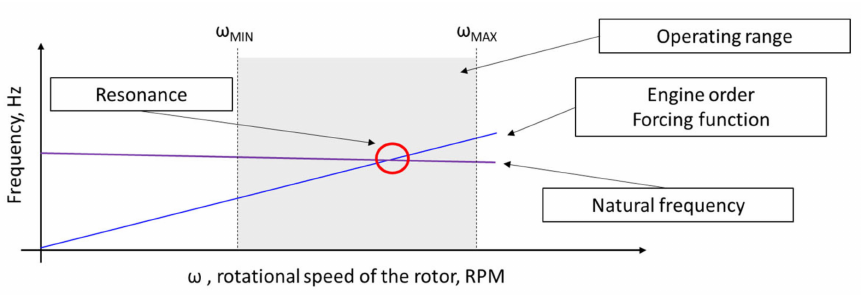
Figure 5. Notional Campbell diagram.